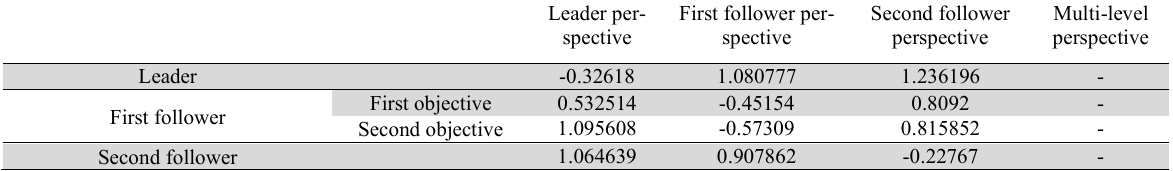
Leader per- spective